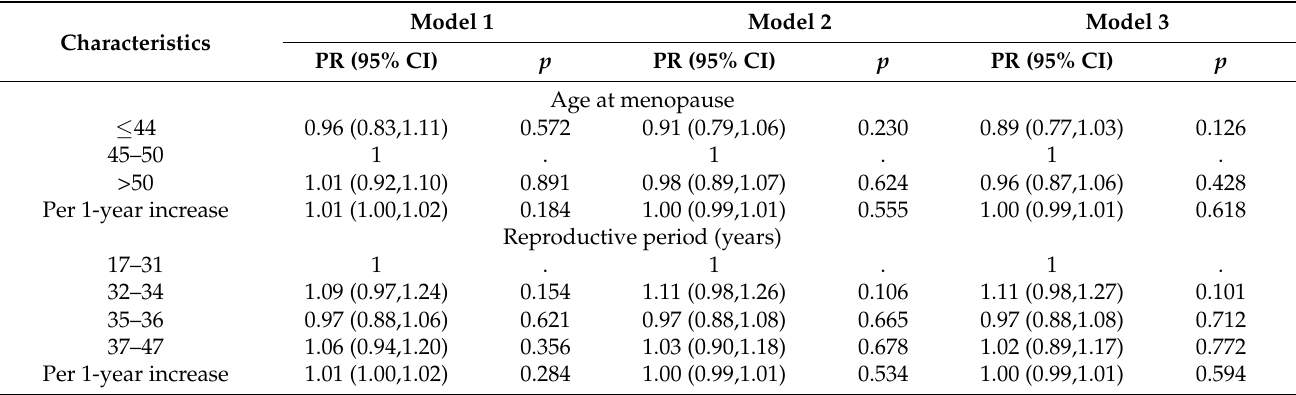
Table 4. Prevalence ratios (PR) (95% CI) for T2DM in postmenopausal women with different age at menopause and reproductive